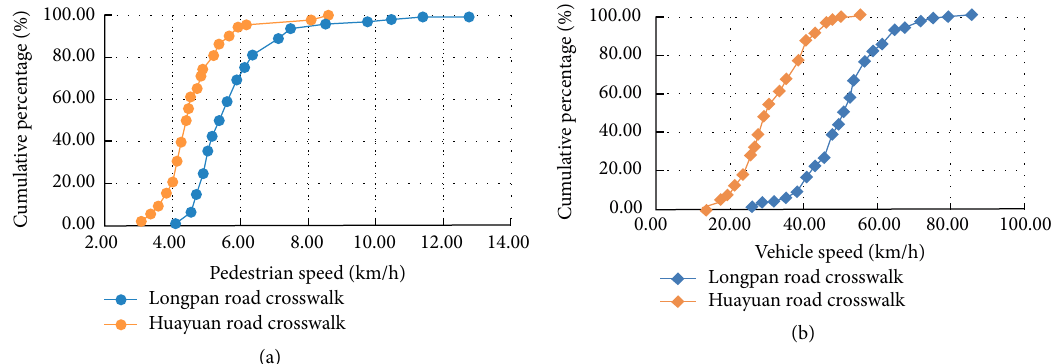
Figure 4: Cumulative distributions of (a) pedestrian speed and (b) vehicle speed at Longpan road crosswalk and Huayuan road